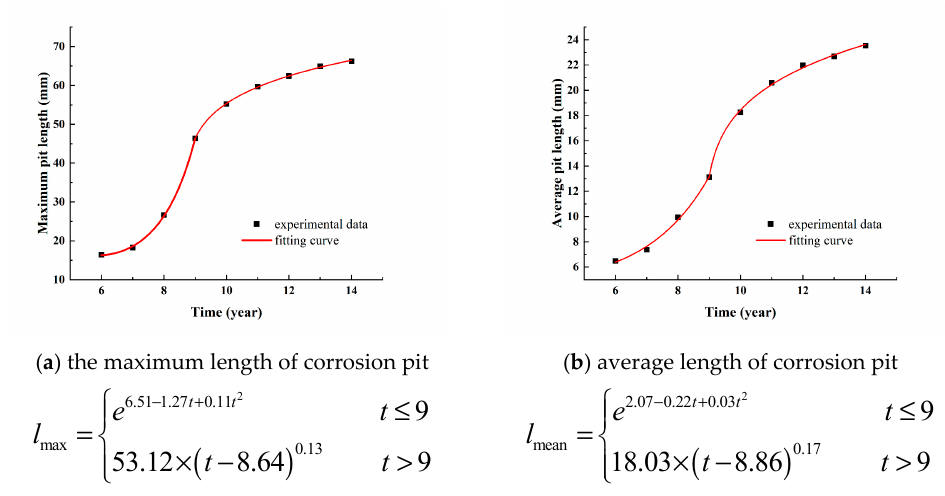
Figure 3. Time-varying fitting curve of corrosion pit length.